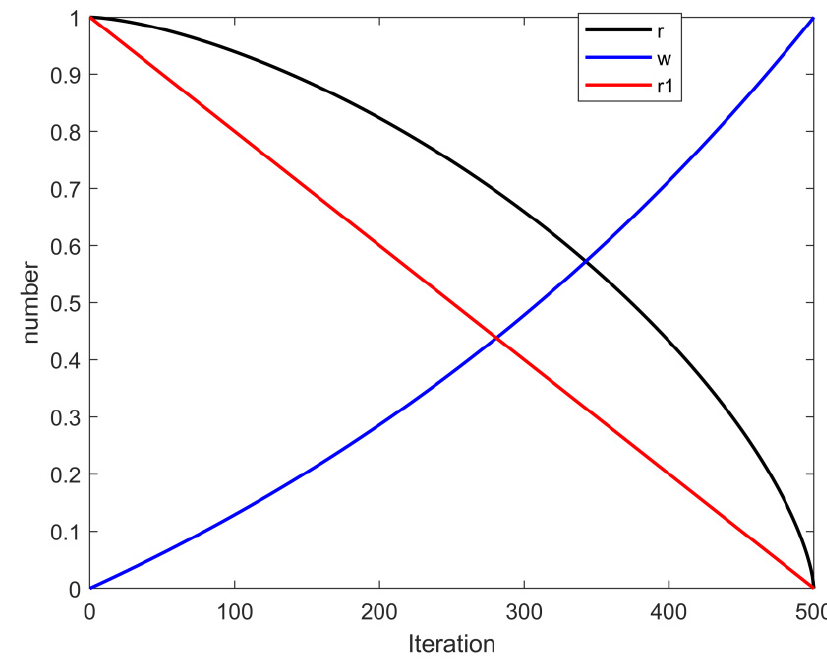
Figure 3. Variation curves of r , 𝜔 and 𝑟 (cid:2869) .